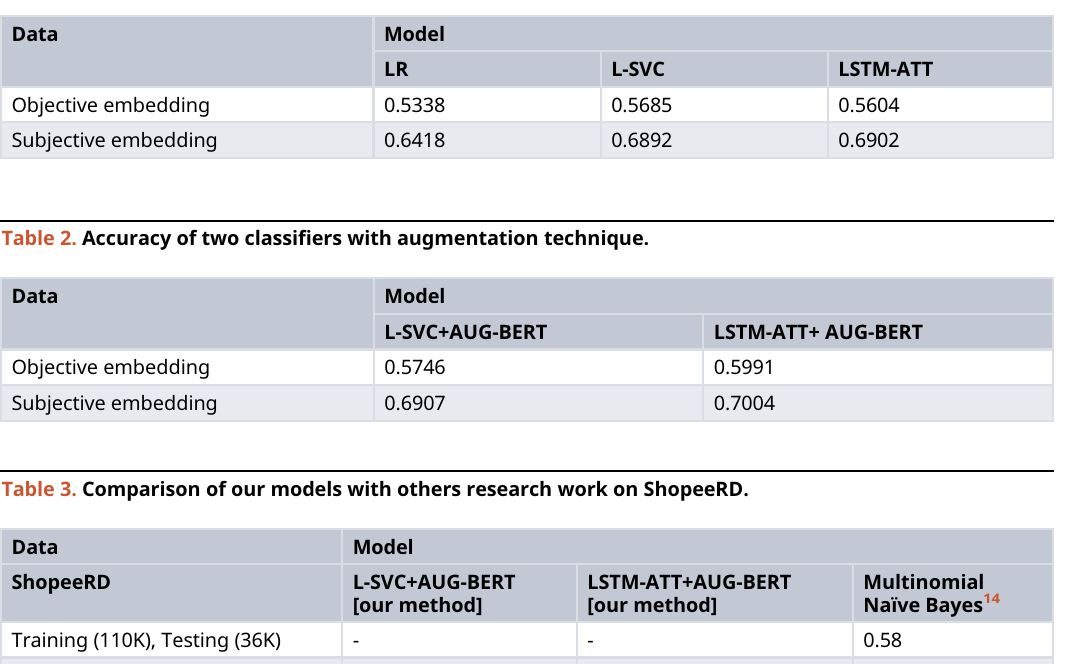
Table 1. Accuracy of three classifiers.